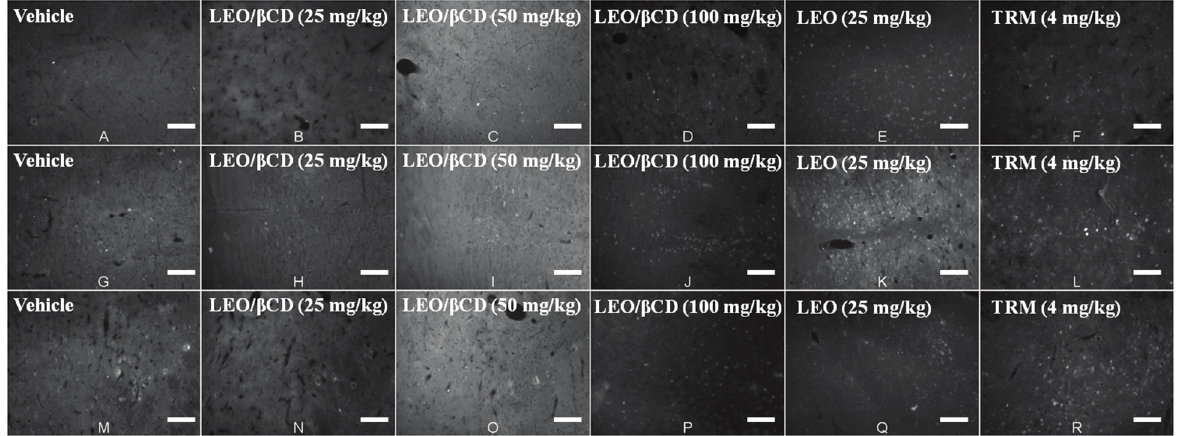
Figure 7. Immunofluorescence staining of nuclear Fos protein in the neurons of the periaqueductal grey ( A – F ); nucleus raphe magnus ( G – L ) and locus coeruleus ( M – R ), 90 min after the treatment with vehicle (v.o.); LEO (25 mg/kg; v.o.), LEO- β -CD (25, 50 and 100 mg/kg; v.o.) and TRM (4 mk/kg;